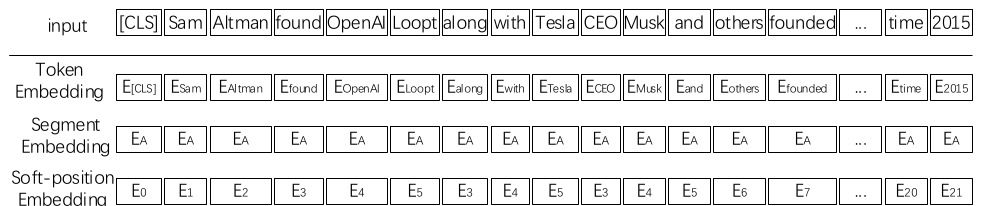
Figure 6. Soft position coding diagram. In the relation tree, the red number is the soft-position index, and the gray is the hard-position index.